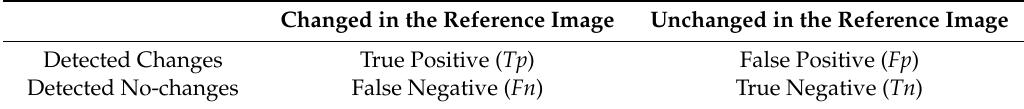
Table 1. The change detection confusion